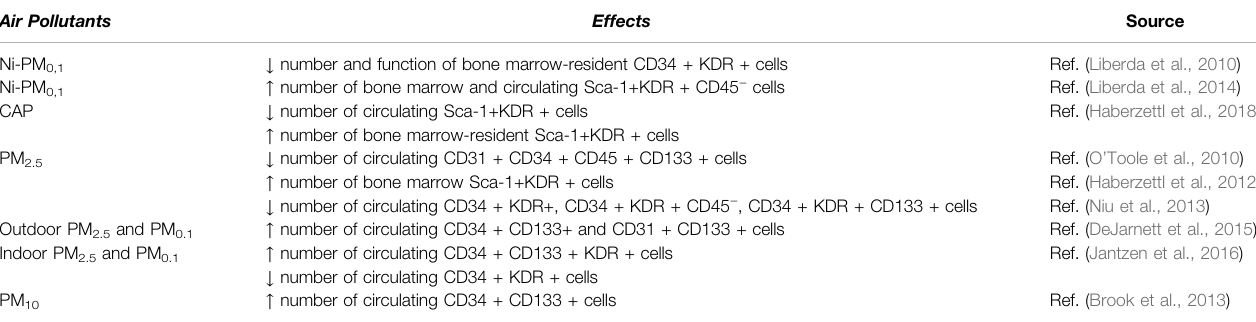
TABLE 2 | Effects of air pollutants on different EPC